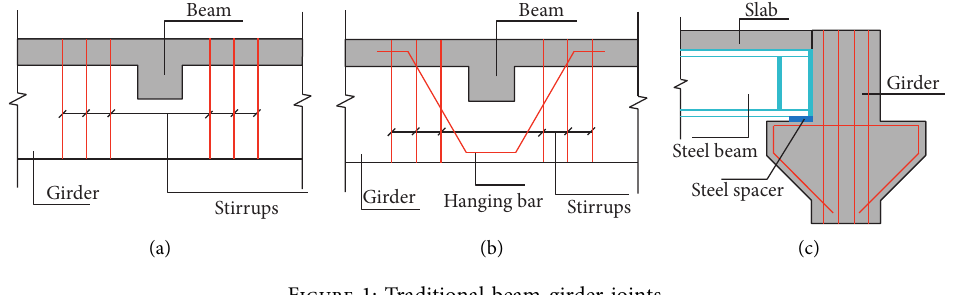
Figure 1: Traditional beam-girder joints.